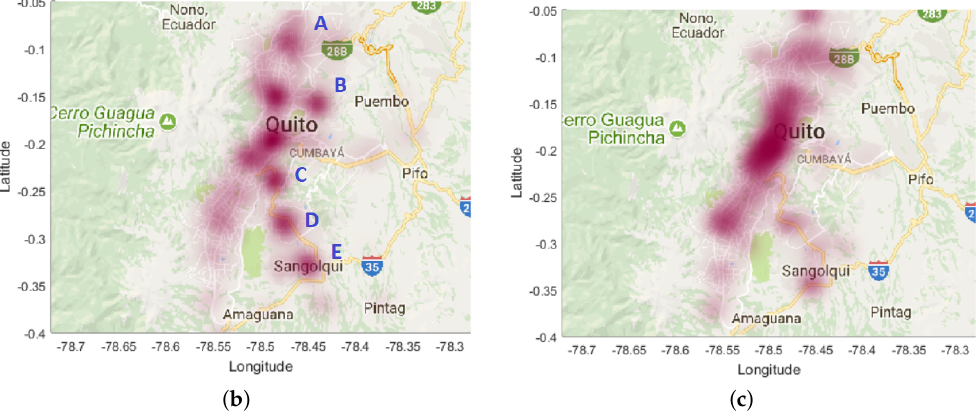
Figure 12. Analysis of transit emergencies. ( a ) Events during 2014, with maximum and minimum peaks; Typical Parzen distribution (red gradient over the map) of transit emergencies registered on a weekend ( b ); and on weekdays ( c ) of a week in December.